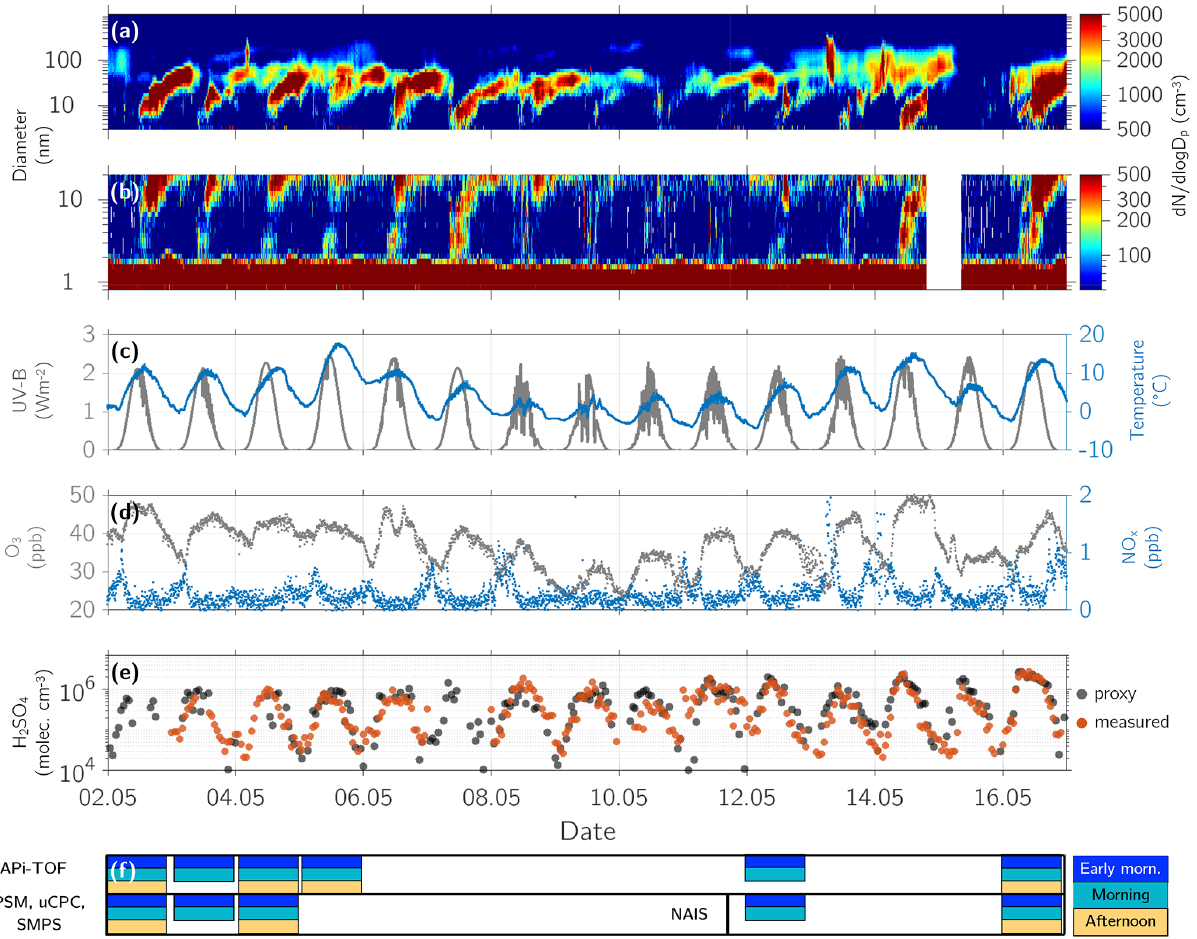
Figure 3. Ground measurements at Hyytiälä, SMEAR II station, from 2 to 16 May 2017. (a) Particle size distribution of particles with a mobility diameter of 3 to 1000nm. (b) Negative ion size distribution of ions in the size range 0.8–20nm. (c) Temperature and UV-B radiation. (d) O 3 and NO x concentration. (e) Sulfuric acid concentration measured (red dots) and calculated with a proxy based on Dada et al. (2020). (f) Data availability of the flight campaign distinguishing between early morning, morning, and afternoon flight, as well as the instrumentation set-up on both airplanes. The instrumentation in the aerosol measurement airplane was changed between 5 and 12 May 2017 from PSM, uCPC, and SMPS to a NAIS. The exact times when the measurements were conducted are shown in Table